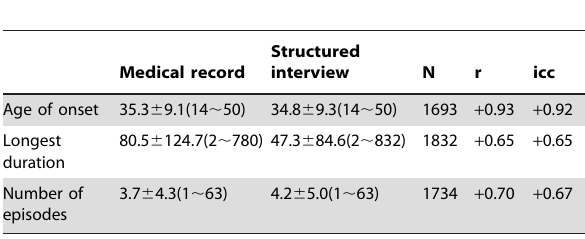
Table 1. Correlation between information obtained from a structured interview and medical records for major depression onset and